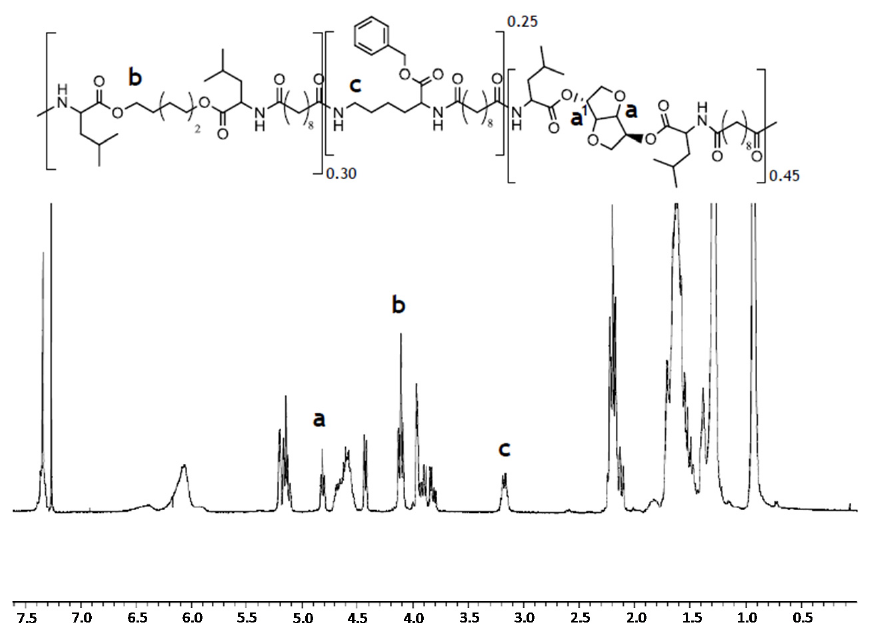
Figure 2. 1 H NMR spectrum of PEA III Ac Bz recorded in deuterated chloroform. The integration of characteristic protons signals at 4.7 ppm (s), 4.1–3.9 ppm (m), and 3.0–2.9 ppm (m) has been used to determine the relative molar ratio of the amino